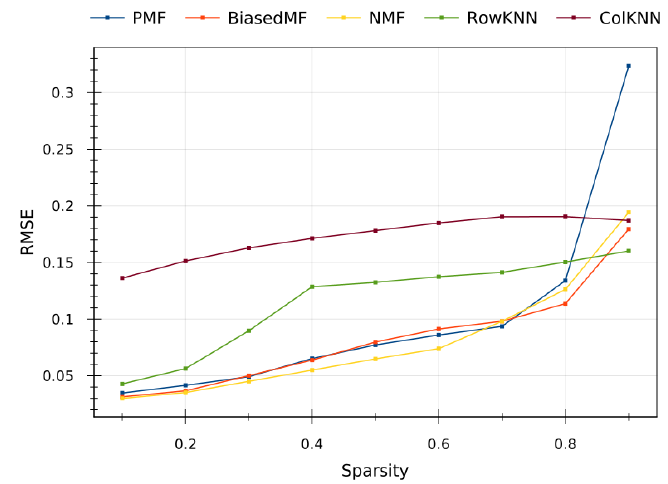
Figure 8. Prediction quality results obtained from the synthetic